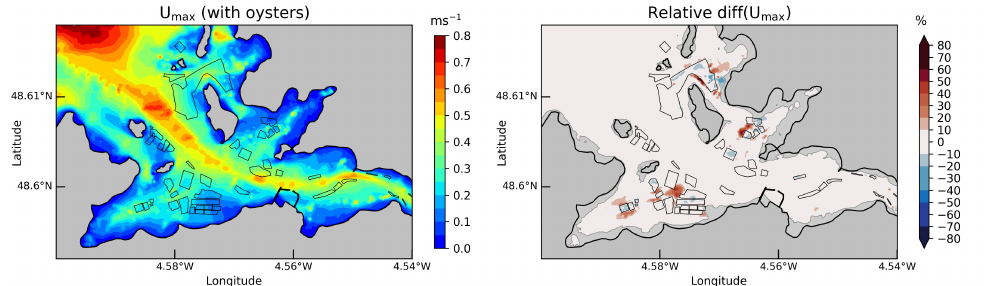
Figure 12. ( left ) Maximum magnitudes of depth-averaged currents in mean spring tidal conditions predicted with oyster tables (E 3 ). ( right ) Relative differences in current magnitudes between sim- ulations with (E 3 ) and without (E 1 ) the effects of oyster tables. Differences are shown for current magnitude over 0.1 ms − 1 . Positive values account for an increase in current magnitude with oyster tables, while negative values exhibit a decrease in current